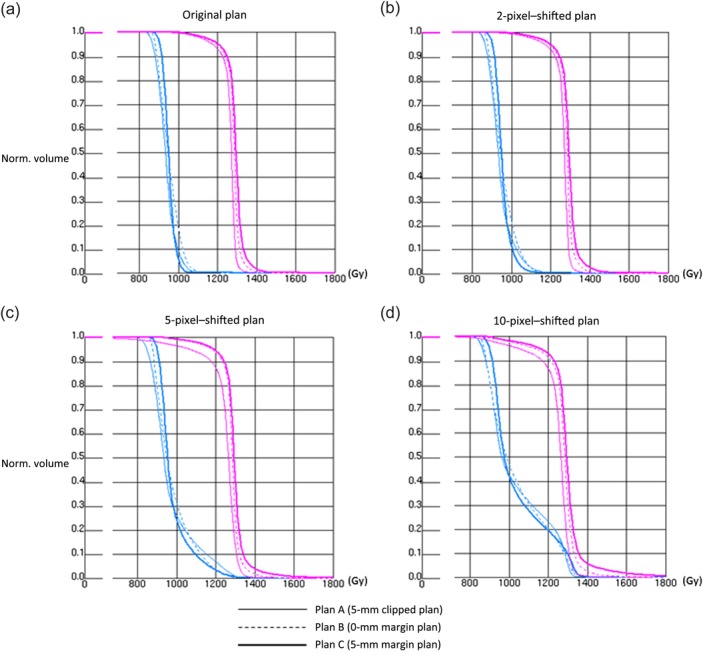
Examples of dose–volume histograms of CTVs and lungs for the original plans (a) and shifted plans (b, c, d). The thin solid lines show the 5-mm clipped plan, the thin dashed lines show the 0-mm margin plan, and the thick solid lines show the 5-mm margin plan. The larger the amount of shift, the worse the homogeneity.